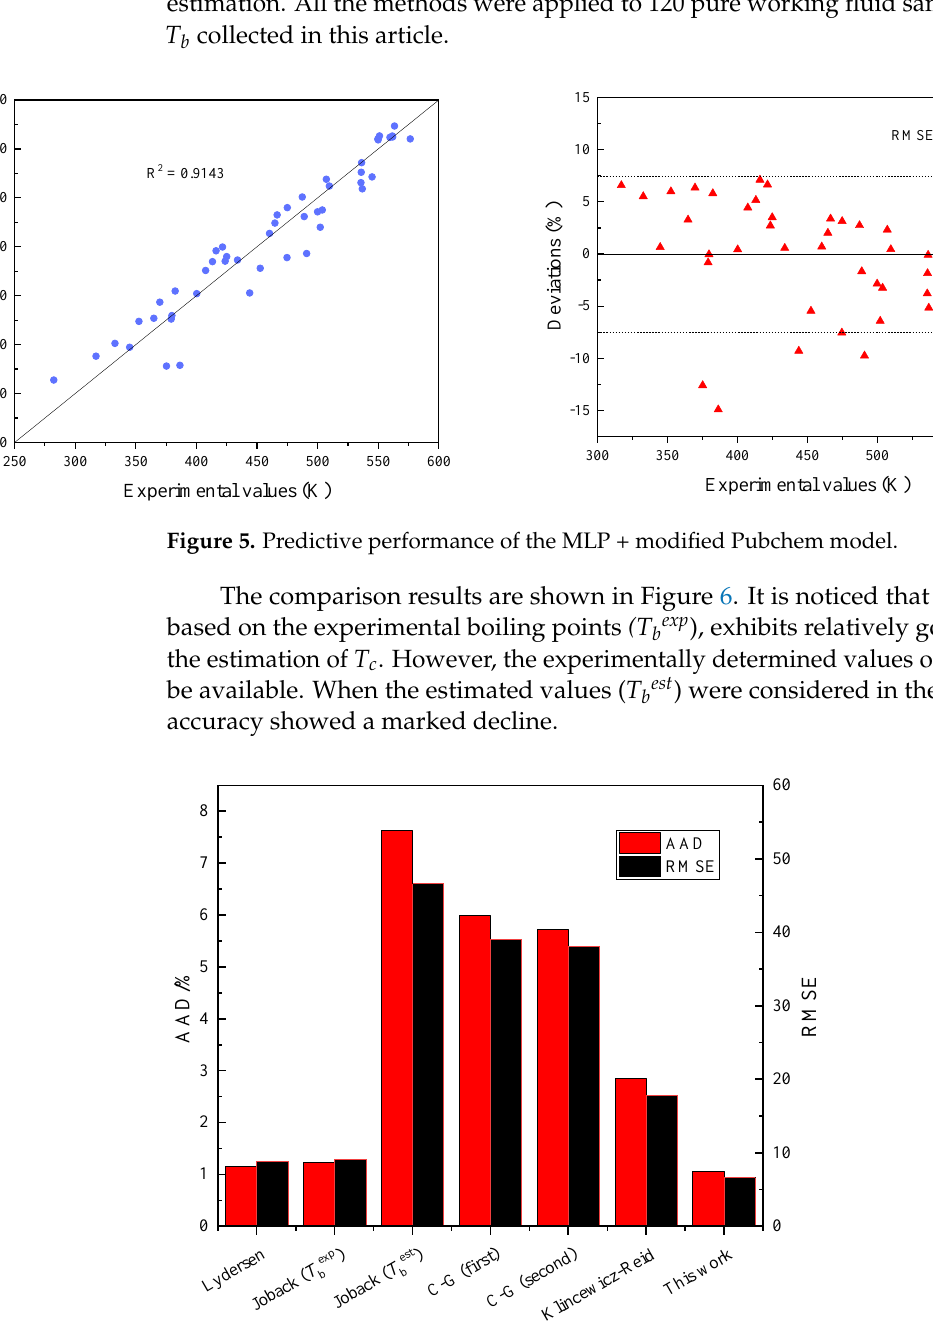
Figure 4. Predictive performance of the SVR + modified Pubchem model.